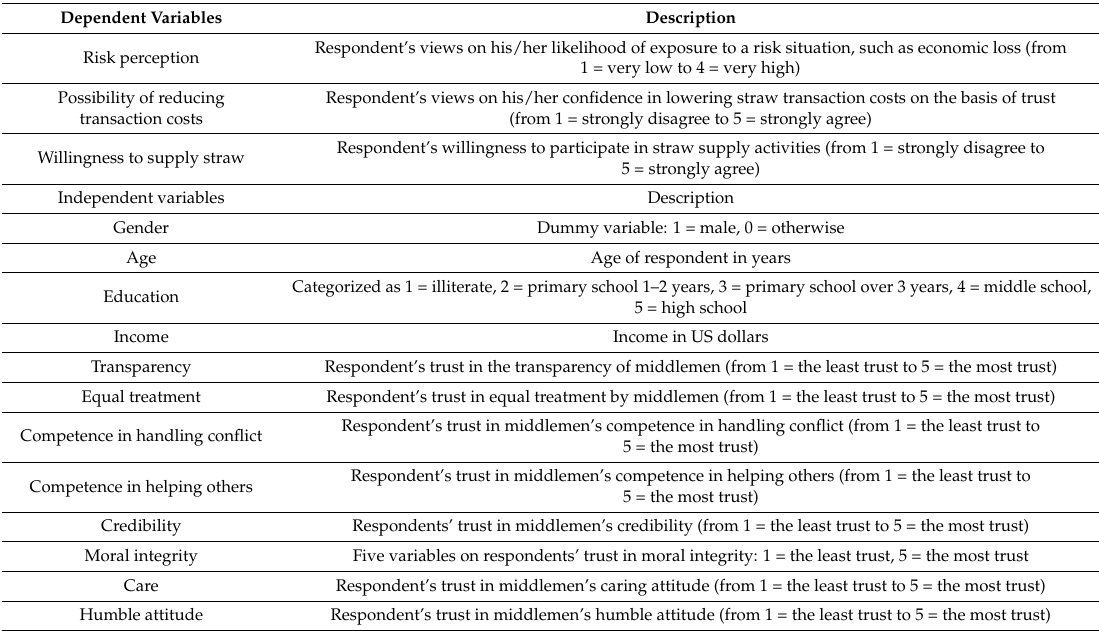
Table 2. Definition of variables.